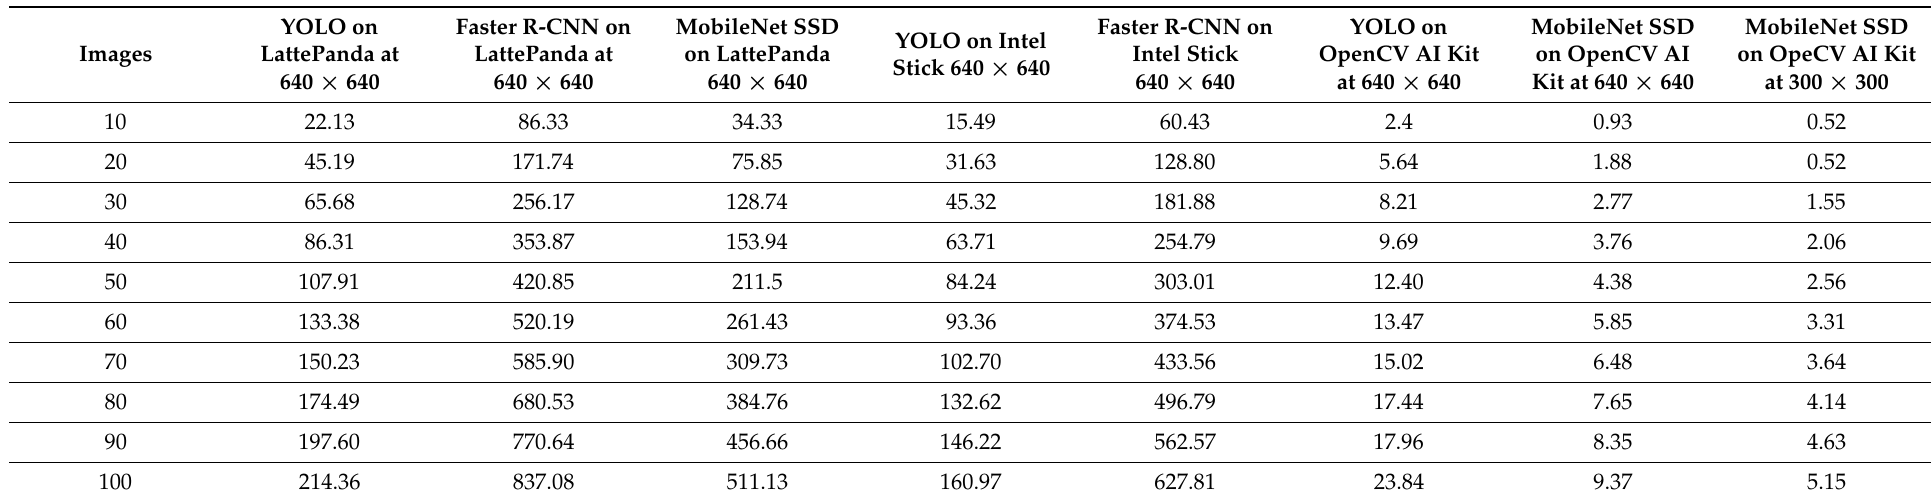
Table 2. Time taken to perform wheat detection on various